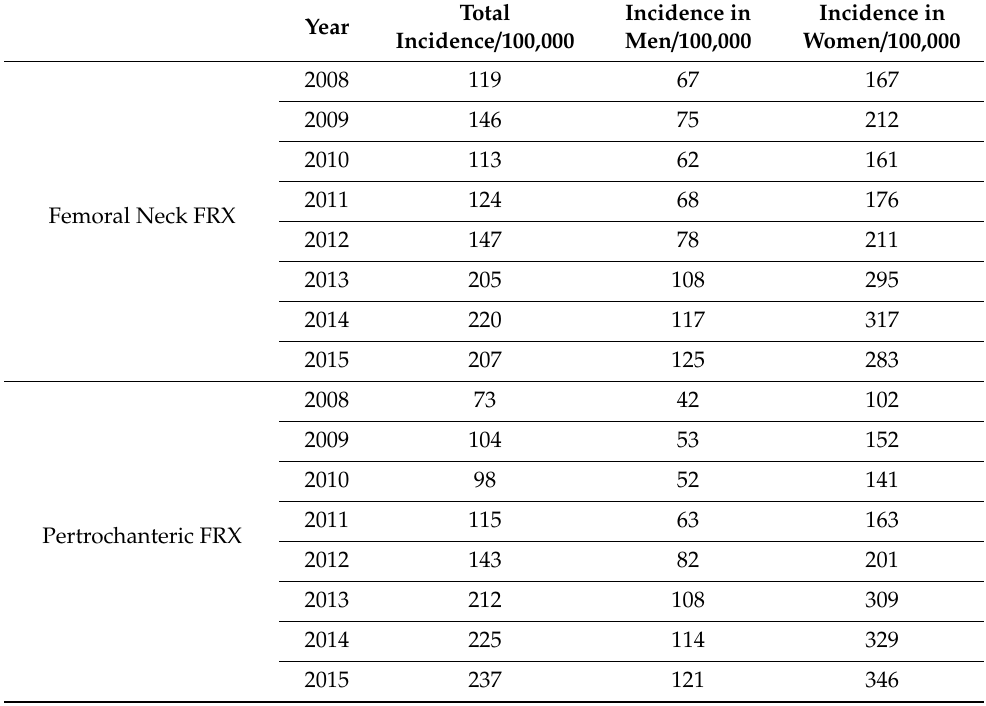
Table 1. The incidence rate of the femoral neck and pertrochanteric fractures per 100,000 population by year. FRX—fracture.